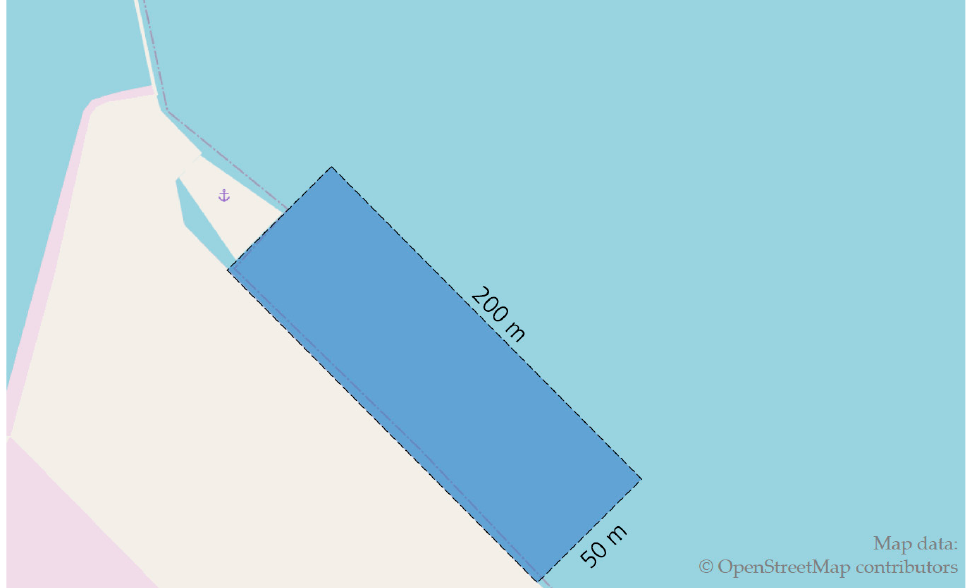
Figure 8 . Geographical region in front of the quay wall where a documentation process is initiated when a vessel enters (Cuxhaven, Germany) .